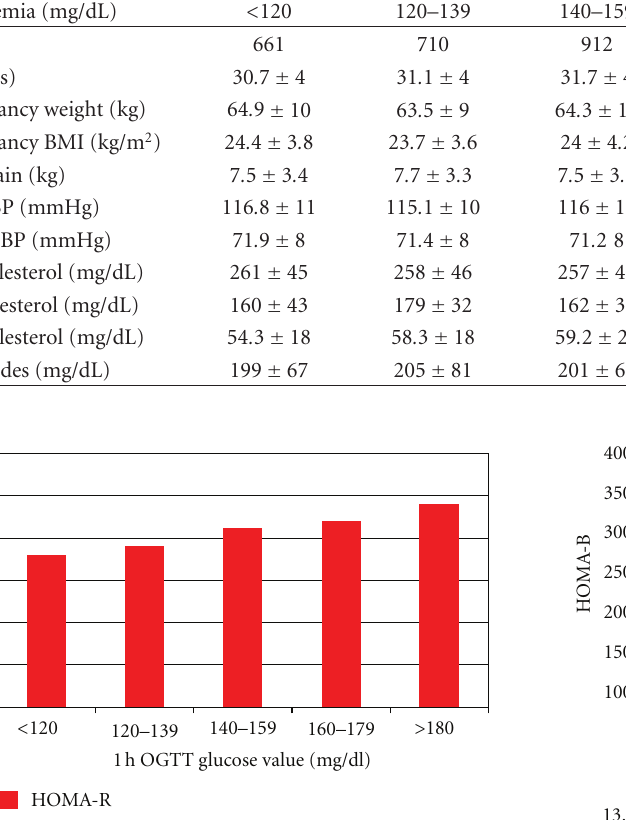
Figure 2: HOMA-R index according to 1-hour OGTT plasma gly- caemia. HOMA-R index is estimated using the formulas proposed by Matthews et al. [7].